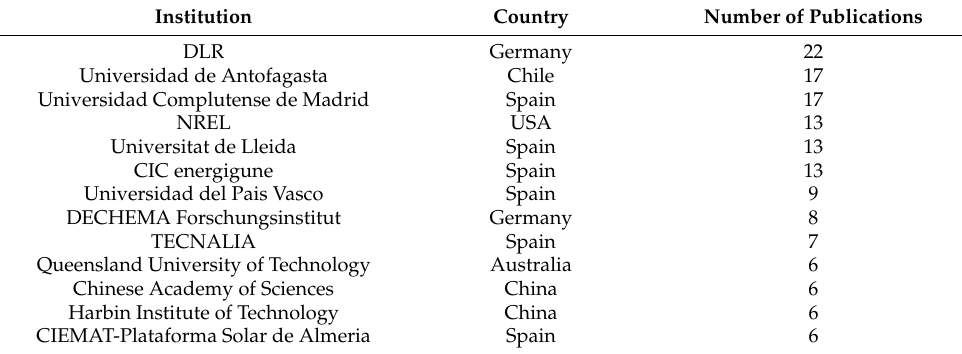
Table 2. Institutions with the highest number of documents